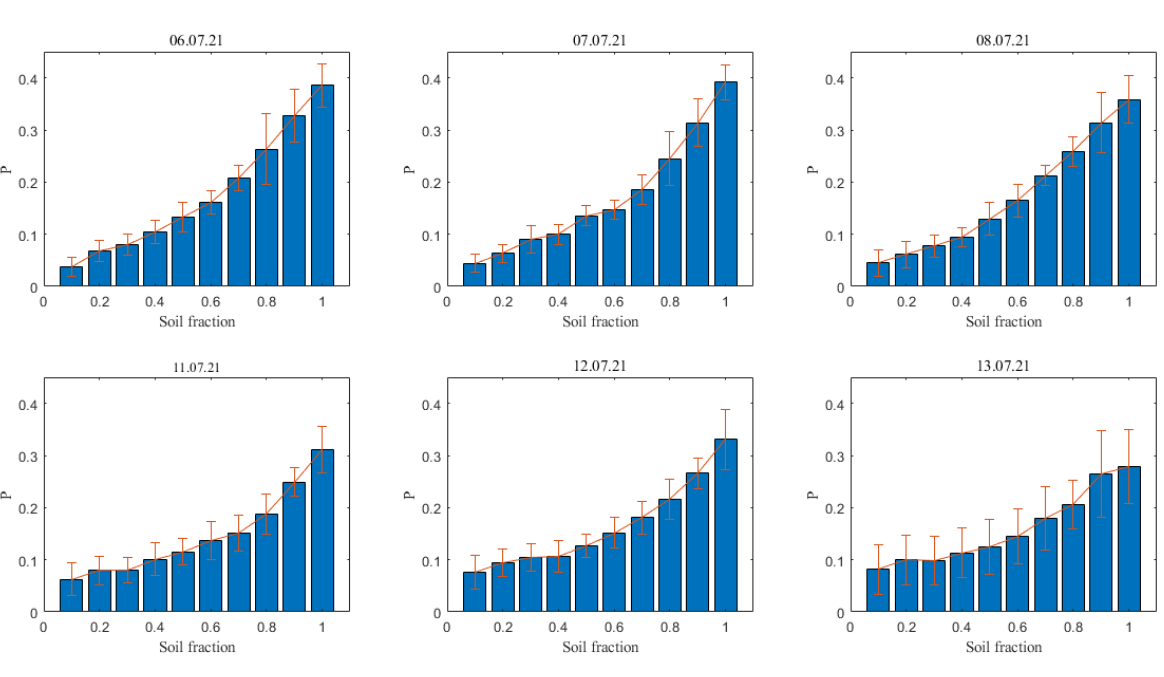
Figure 5 The effect of soil fraction (F) in the pixel on the mean misclassification probability (P) on 6 days of measurments. As the soil fraction increases the probability for misclassification between weed species increase. The mean was calculated based on 5 different sowing plates. Error bars represent the probabilities’ standard deviation.